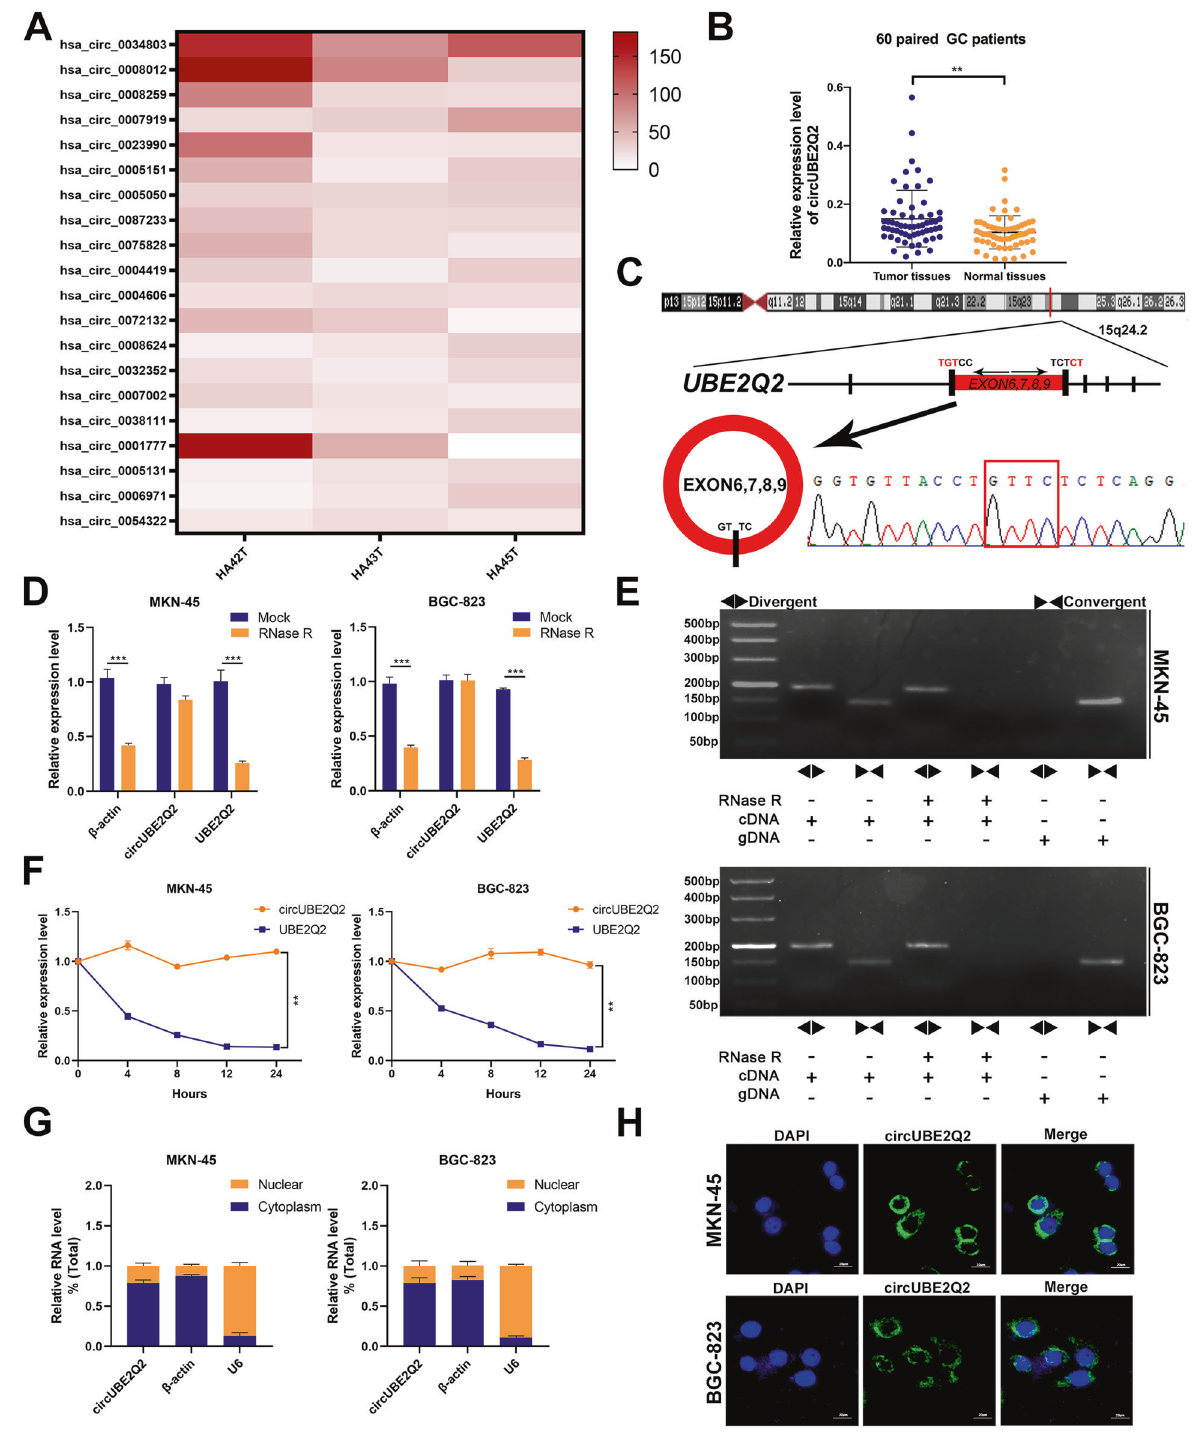
Fig. 1 Identi fi cation of circUBE2Q2 in GC. A Clustered heatmap showing the top 20 differentially expressed circRNAs in three paired human gastric cancer tissues relative to paired normal tissues. B qRT-PCR expression of circUBE2Q2 in GC tissues relative to matched normal tissues ( n = 60). C Sanger-sequencing-validated circular structure of circUBE2Q2. The arrows indicate the splicing sites of circUBE2Q2. D qRT-PCR quanti fi ed the abundance of circUBE2Q2 and linear UBE2Q2 in MKN-45 and BGC-823 cells treated after RNase R treatment. E Agarose gel electrophoresis assay for products of linear and back-splicing ampli fi ed with convergent and divergent primers with and without RNase R treatment. F qRT-PCR analysis of circUBE2Q2 and UBE2Q2 after treatment with Actinomycin D at the speci fi ed time points. G qRT-PCR analysis of the cytoplasm and nucleus of circUBE2Q2, respectively. H Fluorescence in situ hybridization (FISH) for circUBE2Q2 localization, scale bar = 20 µm. Nuclei were stained blue with DAPI. Data are expressed as the mean ± SD. * p < 0.05, ** p < 0.01, *** p < 0.001.